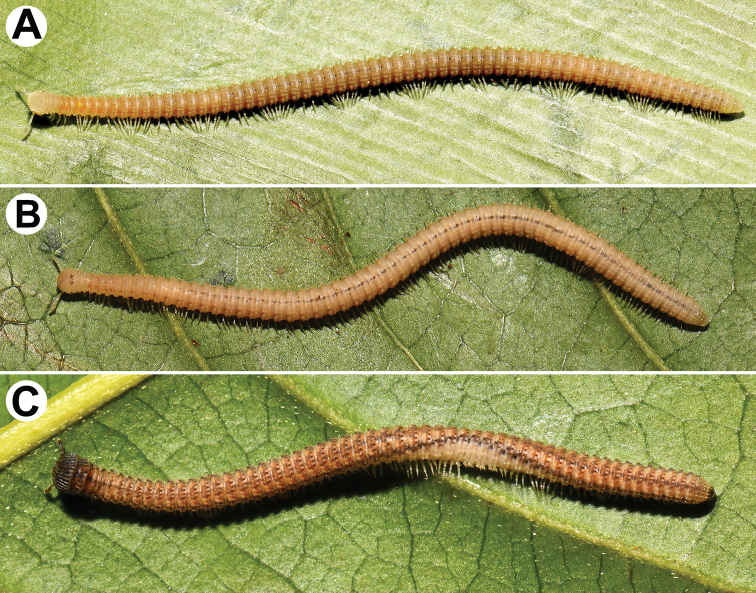
Habitus, live coloration APlusioglyphiulus
boutini Mauriès, 1970, ♂ from Prasat Phnom Totong Temple BPlusioglyphiulus
biserratus sp. nov., ♀ paratype CPlusioglyphiulus
khmer sp. nov., ♂ paratype. All pictures by R. Srisonchai, not taken to scale.